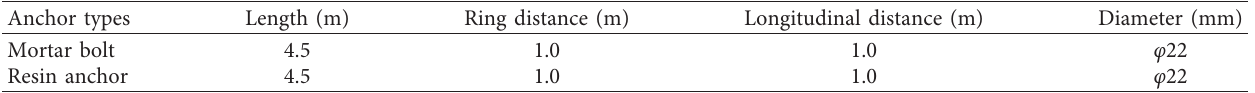
Table 3: Bolt support parameters.